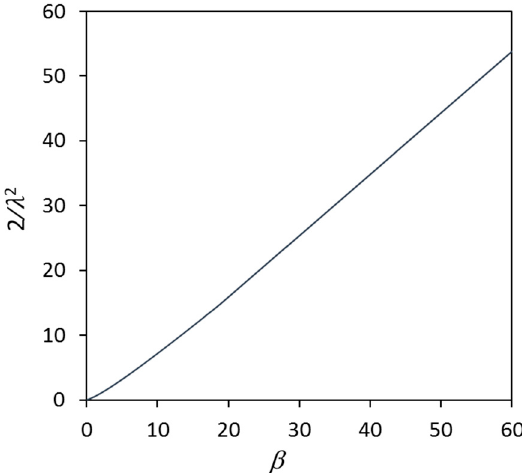
Figure 1. Schematic phase diagram of a binary A-B system showing the definitions of the relevant parameters related to growth restriction, such as P , Q and ∆ T s . When C 0 ≤ C B , P = ∆ T s ; when C 0 > C B , P > ∆ T s , e.g., C 0 = C.